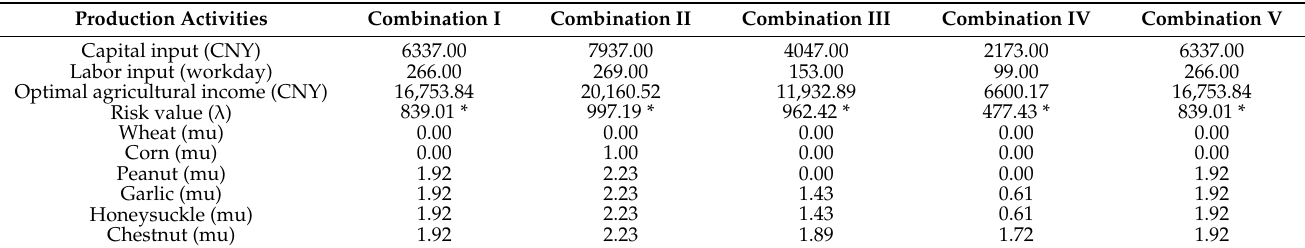
Table 14. Optimal allocation of agricultural input factors and production combinations for different types of peasant households.